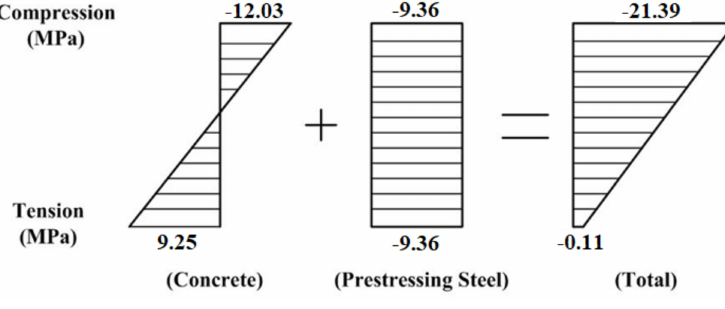
Figure 21. Total stress on